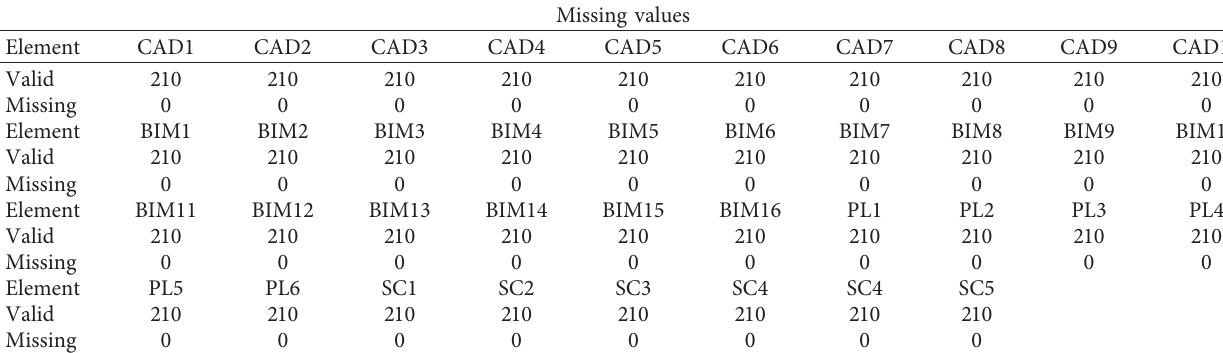
Table 1: Missing values.